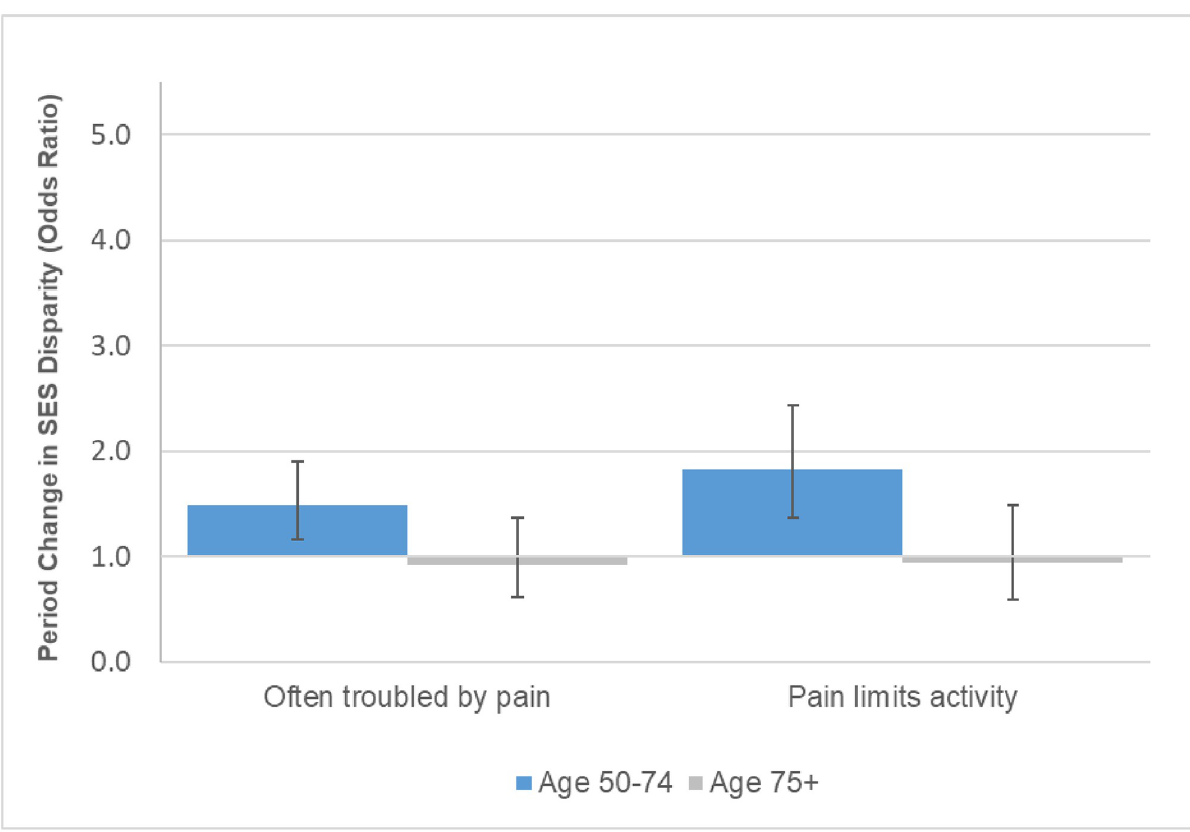
Fig 7. Changes over time in socioeconomic disparities in overall pain by age group, HRS 1996–2016. The SES disparity was computed as the odds ratio for the 90 th versus the 10 th percentile of SES. The estimates were based on models fit separately for the two age groups. All models adjusted for sex, age (linear specification), race/ethnicity, period (categorical specification), and SES. The models also included the following 2-way interactions: age x period; age x SES; and period x SES.